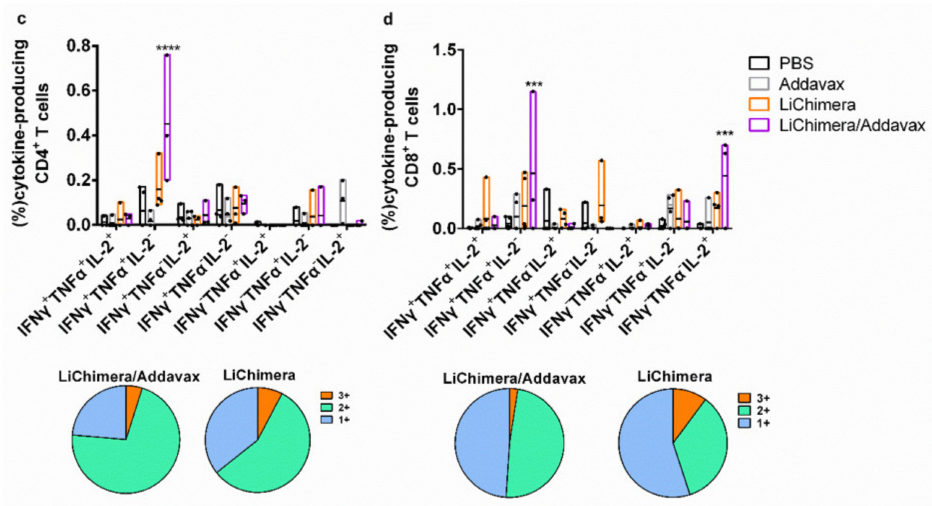
Figure 7. Determination of the multifunctionality of antigen-specific T cell responses following vaccination with LiChimera. The BALB / c mice were vaccinated twice intramuscularly with LiChimera alone or adjuvanted with Addavax. The control groups received PBS or Addavax. Two weeks post boosting, spleen cells were isolated and splenocytes were stimulated in vitro with LiChimera or pools of MHCI- or MHCII-restricted peptides for 12 h. For the antigen-specific CD4 + and CD8 + T cells, the magnitudes and quality of responses were assessed using flow cytometry multiparametric analysis. Cytokine-producing cells within the CD4 + and CD8 + T cell populations were divided into seven distinct subpopulations based on their production of these cytokines in any combination after ( a , b ) LiChimera, ( c ) MHCII-restricted peptides, and ( d ) MHCI-restricted peptides ex vivo stimulation. The pie charts summarize the fractions of single, double, or triple producers for indicated groups. Flow cytometry results are given as bounds of box and whisker plots. The line represents the median ( n = 3–4 mice per group), the whiskers show the data range, and the box shows the interquartile range. Significant di ff erences between groups are indicated with asterisks measured by two-way ANOVA and Tukey’s multiple comparison tests. * p < 0.05, *** p < 0.001, and **** p < 0.0001.